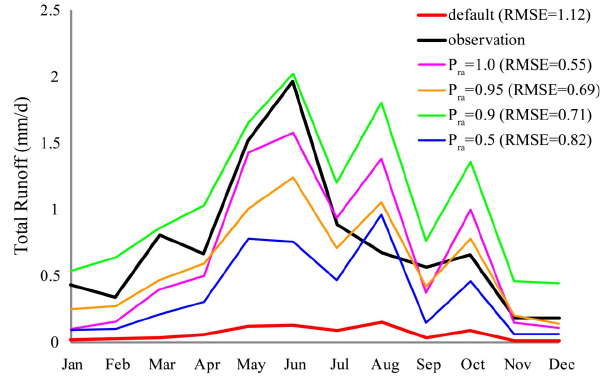
Figure 8. Simulated runoff using the posterior estimates of parameters at the MOPEX basin. 819 Fig. 8. Simulated runoff using the posterior estimates of parameters at the MOPEX